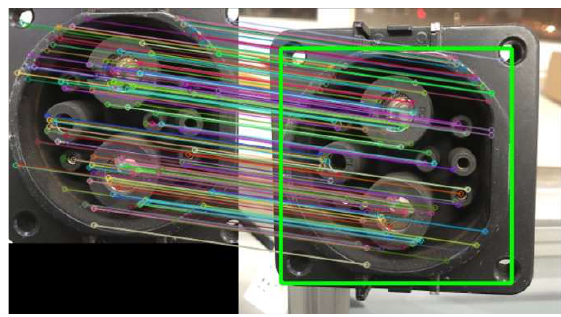
Figure 8. Feature matching results.